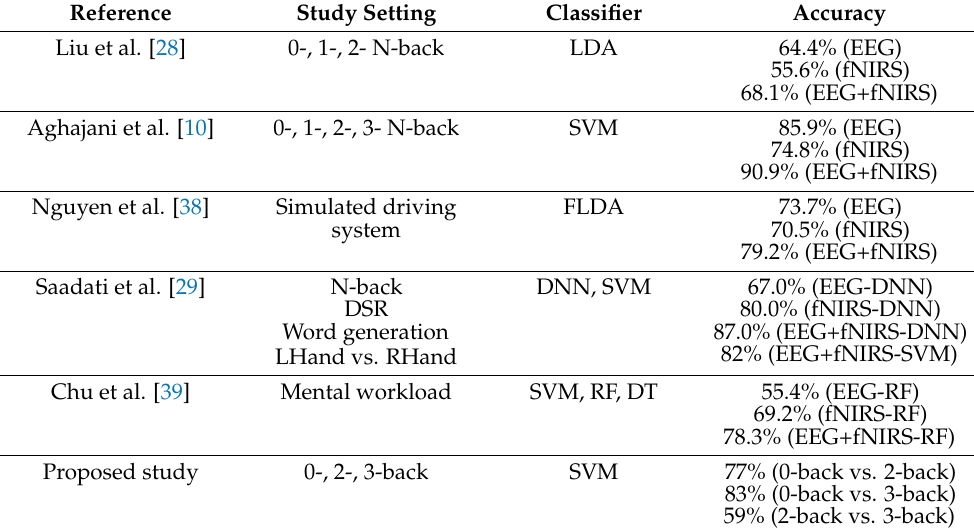
Table 6. A comparative analysis of the previous research and the proposed work.